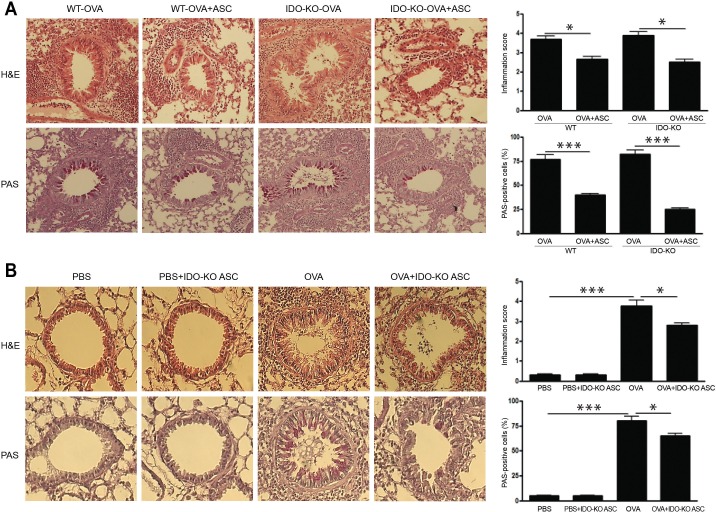
Effects of adipose-derived stem cells (ASCs) on lung inflammation and goblet cell hyperplasia.ASCs or ASCs derived from indoleamine 2, 3-dioxygenase (IDO)-knockout (KO) mice decreased the infiltration of eosinophils and PAS-positive cells around the airways and blood vessels in wild-type (WT) and IDO-KO asthmatic mice (H&E, PAS ×200). ASCs (A) or IDO-KO ASC (B) treatment significantly reduced the inflammation score and PAS-positive cells. Data are expressed as the mean ± SEM of four independent experiments performed in triplicate. *
p<0.05, ***
p≤0.001.